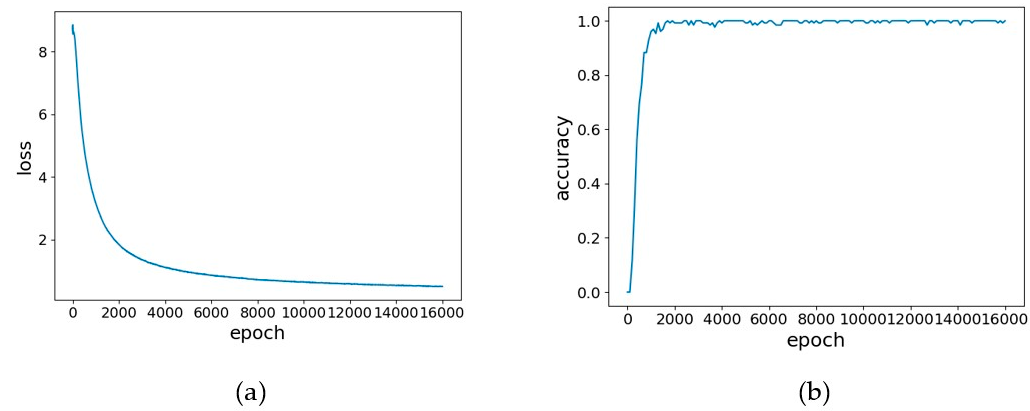
Figure 7. ( a ) The descending curve of the loss value on the train set. ( b ) The rising curve of the accuracy on the test